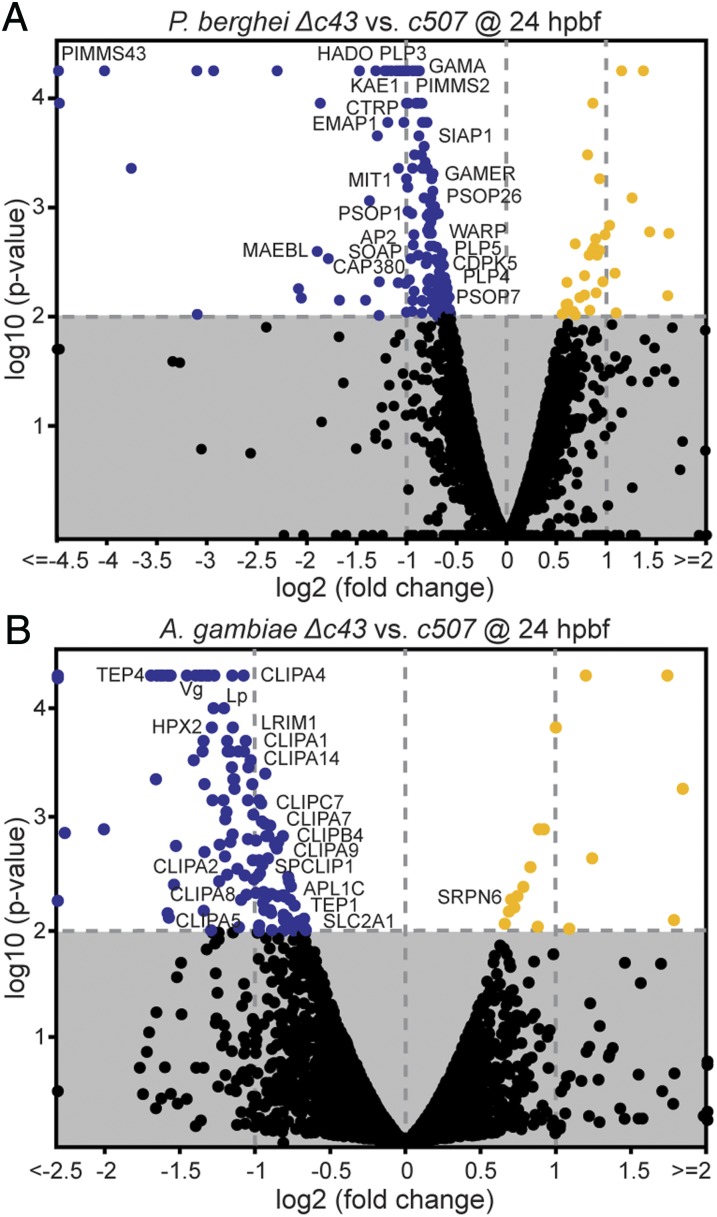
P. berghei and A. coluzzii gene expression 24 hpbf. (A) Volcano plot of P. berghei gene expression in Δc43 vs. c507 wt parasite lines in the A. coluzzii midgut. (B) Volcano plots of A. coluzzii midgut transcriptional responses to Δc43 vs. c507 wt parasites. The x axes show log2 fold-change and y axes show log10
P value calculated using one-way ANOVA. Blue and orange filled circles indicate genes that are at least twofold down down-regulated and twofold up-regulated, respectively. Black circles show with no significant differential regulation. Known gene names are indicated.